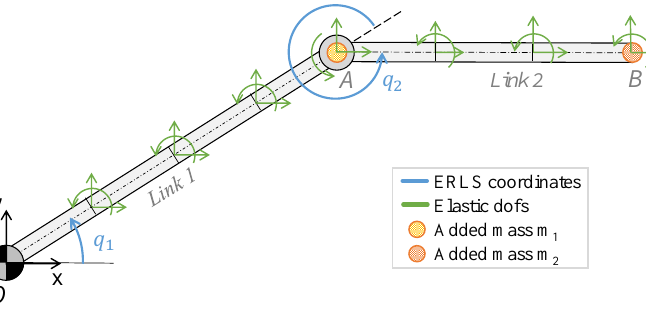
Figure 1. Finite element model of the flexible-link manipulator. Table 1. System parameters of the two-link mechanism.